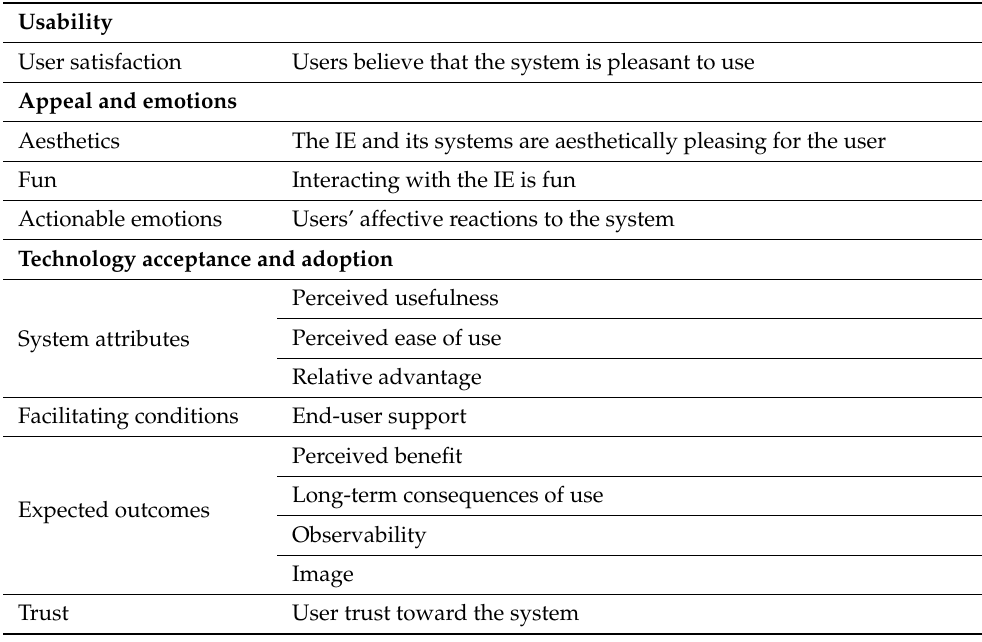
Table A7. UXIE metrics to be assessed through questionnaires long after a user-based